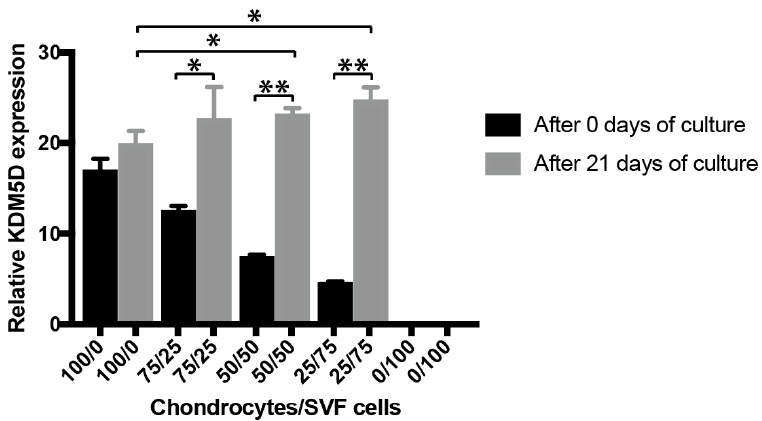
Figure 4. Relative lysine demethylase 5D (KDM5D, y-chromosomal) gene expression to 18S of male chondrocytes after 0 days and 21 days of culture. Results are expressed as mean ± SD and analysed with an unpaired t -test when different pellets of co-cultures were compared. A paired t -test was used when the same co-culture was analysed at different timepoints. * p ≤ 0.05. ** p ≤